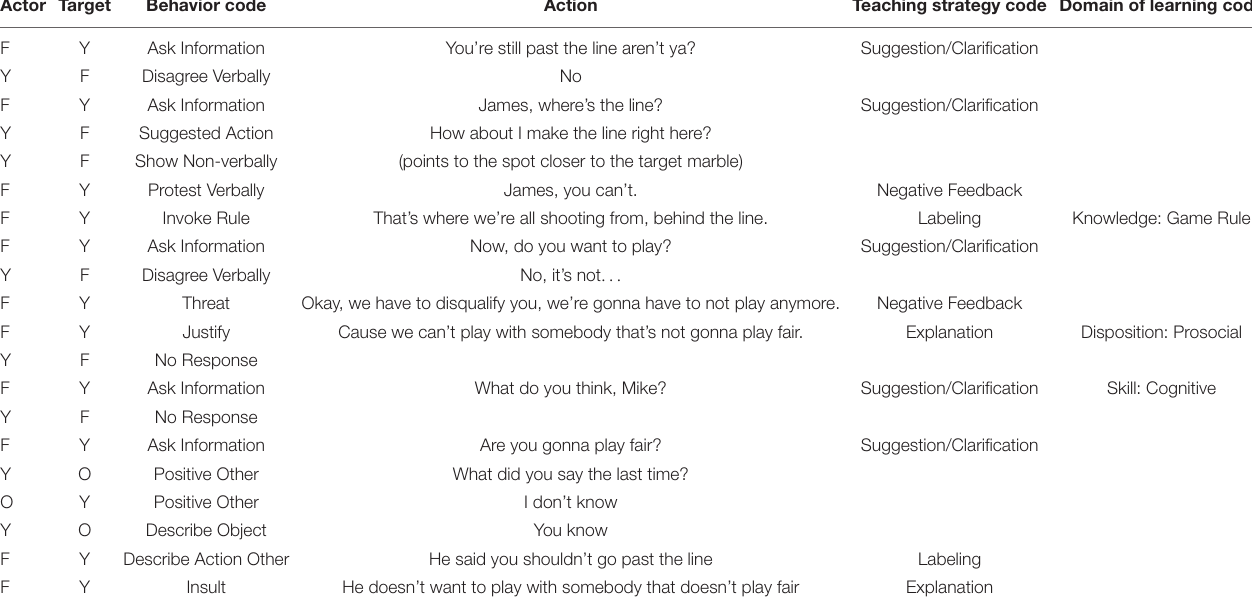
TABLE 1 | Sample teaching sequence. Actor Target